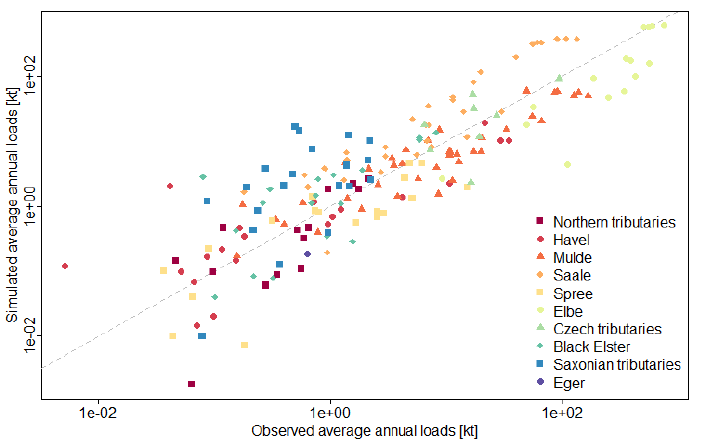
Figure 4. Comparison of observed and simulated average annual suspended sediment loads. Each point corresponds to a measurement site in the Elbe basin. The dashed grey line represents the 1:1-line.